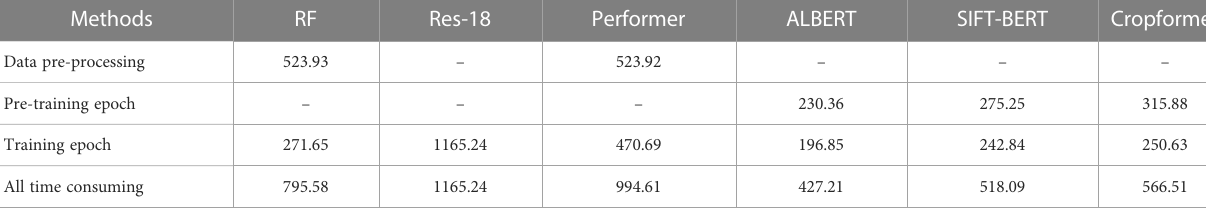
TABLE 5 Comparison of processing speed between cropformer and other methods(s).